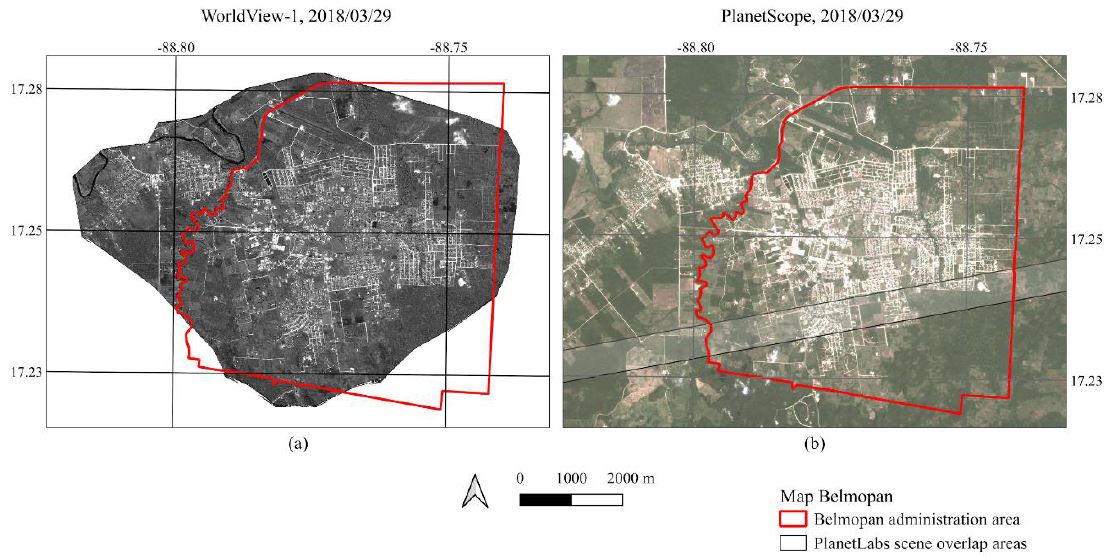
Figure 3. Overview of satellite imagery used for the study. The red polygon shows the Belmopan city boundary. ( a ) WorldView-1 image covering the developed areas of Belmopan. ( b ) PlanetScope images fully covering Belmopan.